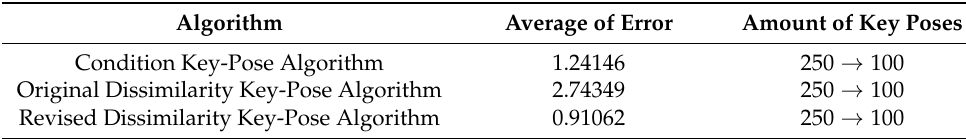
Table 3. Comparison of the three key-pose detection